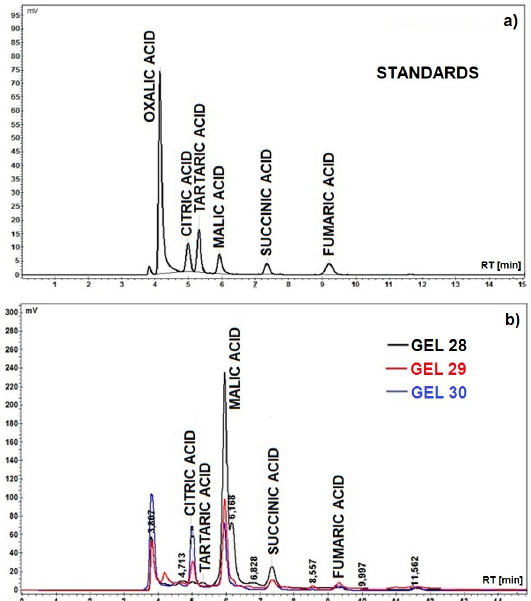
Figure 1. ( a ) Chromatogram of the standard mixture (1 mg / mL) of studied organic acids: oxalic acid (RT = 4.145 min), citric acid (RT = 4.987 min), tartaric acid (RT = 5.310 min), malic acid (RT = 5.925 min),